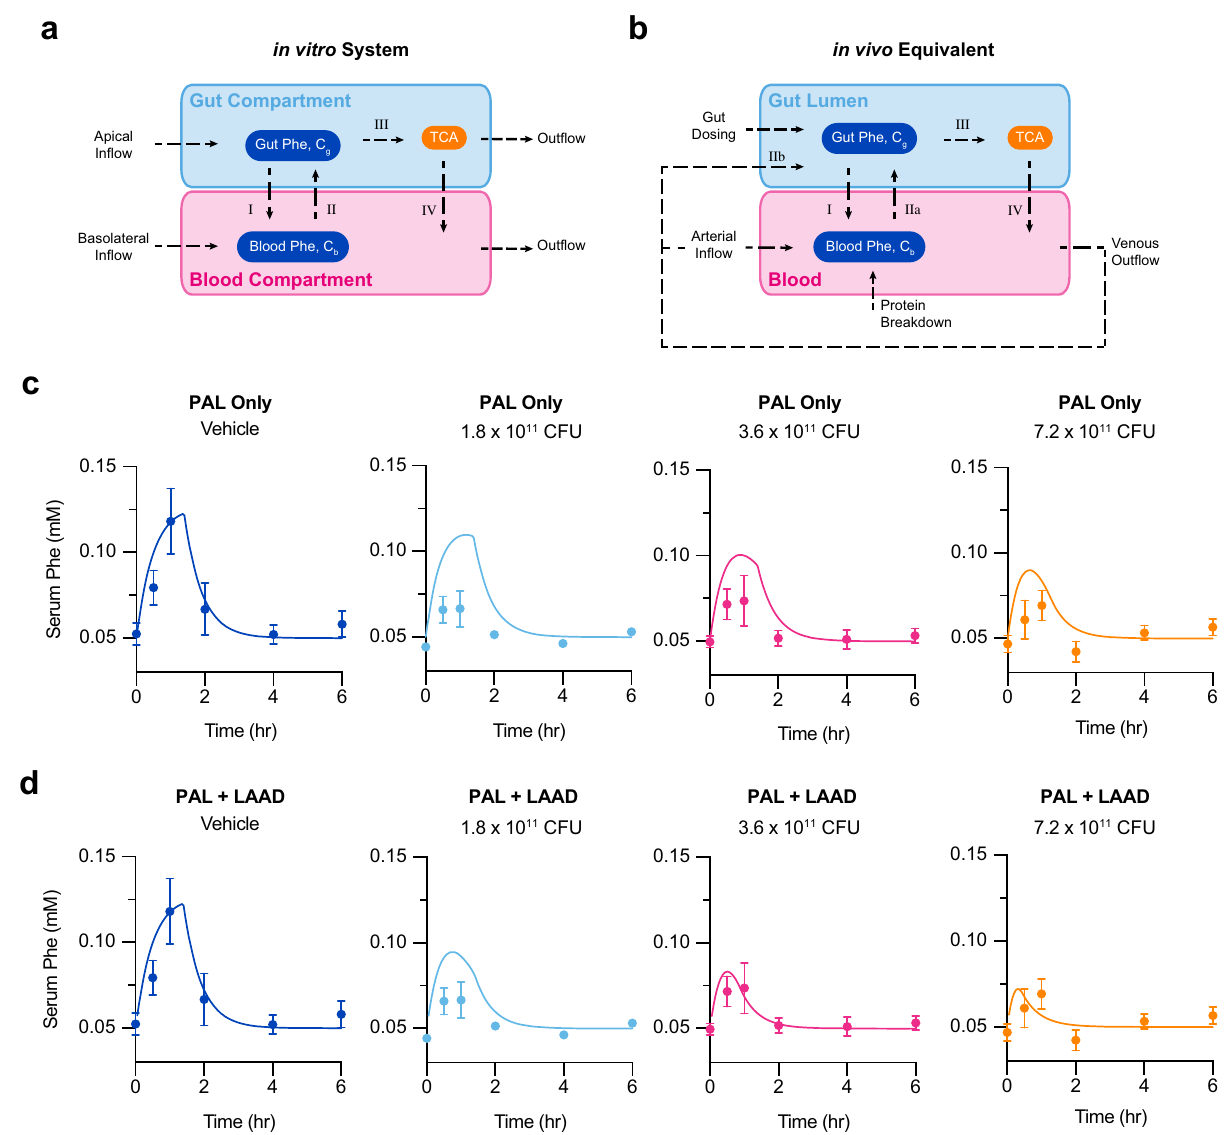
Fig. 5 Computational models of Phe kinetics in NHP dosed with SYNB1618. a , b Schematic representations of Phe kinetics in gut-chips ( a ) and in vivo ( b ). Arrows labeled I-IV represent equivalent processes in the two systems as follows: (I) Uptake of Phe from gut to blood via permeability-surface area product, PA , (II) Excretion of Phe from blood to the gut, (III) Metabolism of Phe to TCA by SYN5183 or SYNB1618, normalized to CFU number, and (IV) absorption of TCA from gut to blood via PA . For ( b ), the complex in vivo process of hepatic enterorecirculation (IIb) is not implemented in the computational model. Instead, this process is described by direct diffusion from the blood to the gut compartment (IIa), as in the gut chip. c Serum Phe concentrations for NHP orally dosed with SYNB1618 and the corresponding in vivo model simulations, assuming PAL activity only. d Serum Phe concentrations for NHP orally dosed with SYNB1618 and the corresponding in vivo model simulations, assuming both PAL and LAAD enzyme activity. For ( c , d , in vitro results were acquired from three independent gut chips and extrapolated to published NHP data 4 ), points with errors bars indicate experimental data from Isabella et al. 4 , and solid lines represent simulate data. NHP were dosed at 0 h with a 5.0 g peptone bolus and 0 – 7.2 × 10 11 CFU SYNB1618 4 , error bars represent standard deviation with the middle point representing the mean value. Source data are provided as a Source Data fi